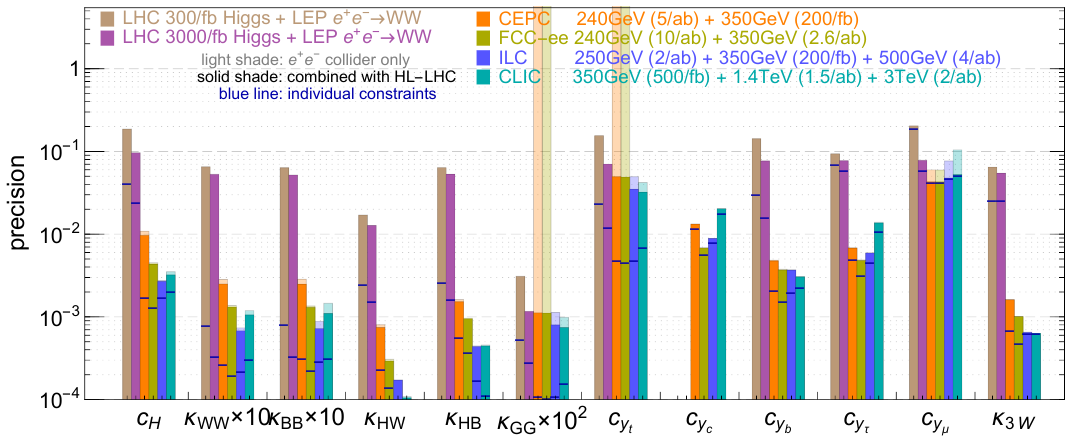
Figure 14 . Same as (cid:12)gure 7 but is in the SILH’(-like) basis de(cid:12)ned by eq. (A.8) and table 1. here for the FCC-ee and ILC in (cid:12)gure 15{21. In particular, (cid:12)gure 16 shows the precision reach for ILC with di(cid:11)erent scenarios including runs at 250 GeV, 350 GeV and 500 GeV, while (cid:12)gure 17 further shows the potential improvement with the inclusion of a 1 TeV